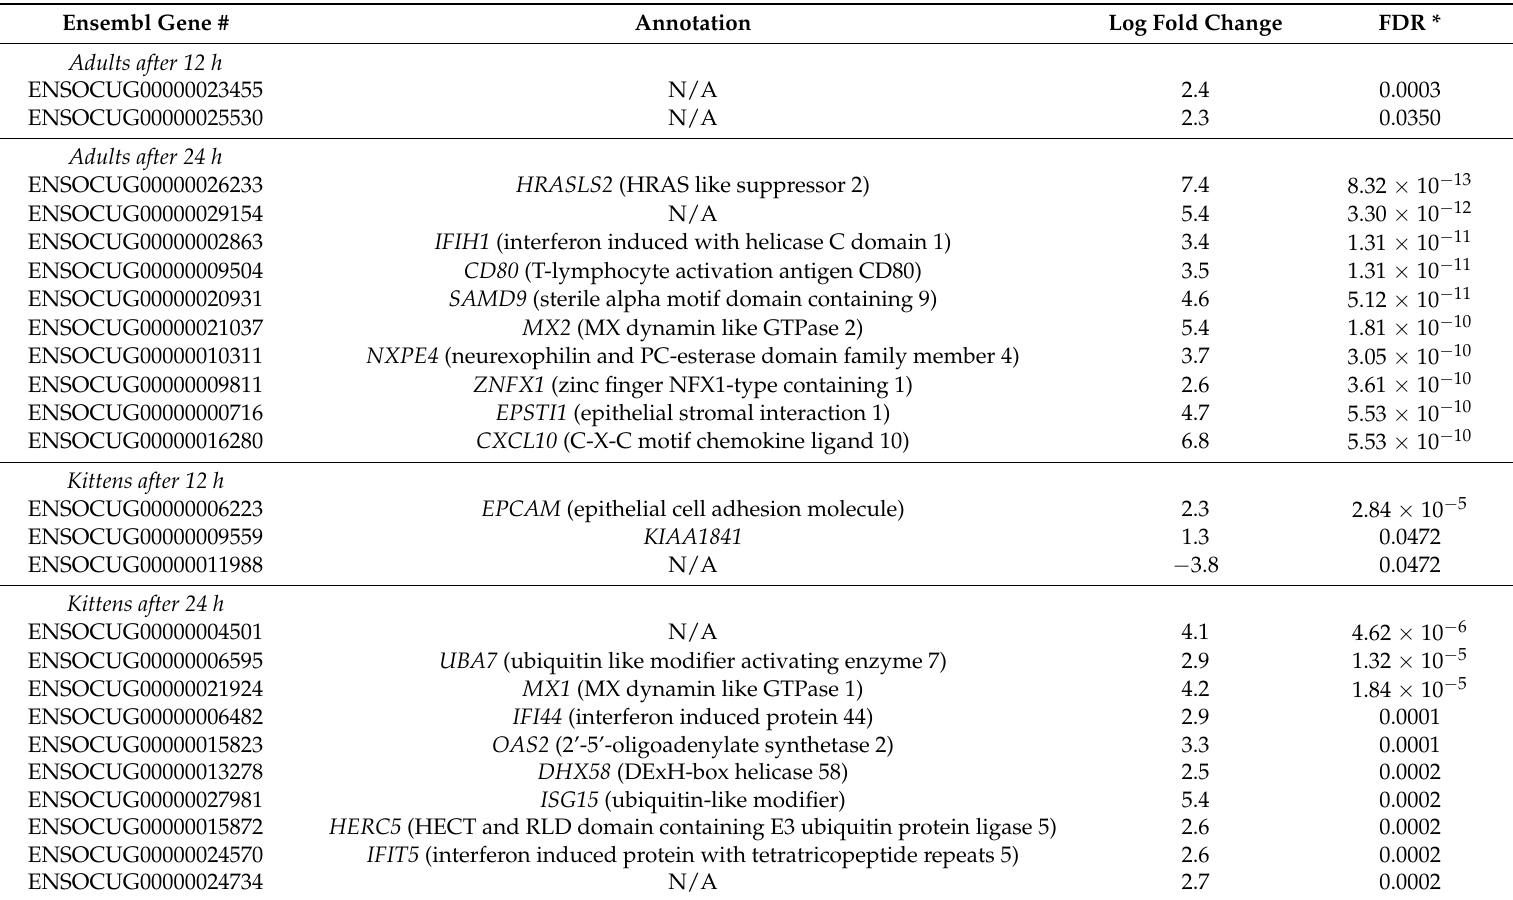
Table 4. The top differentially expressed genes in GI.1-infected